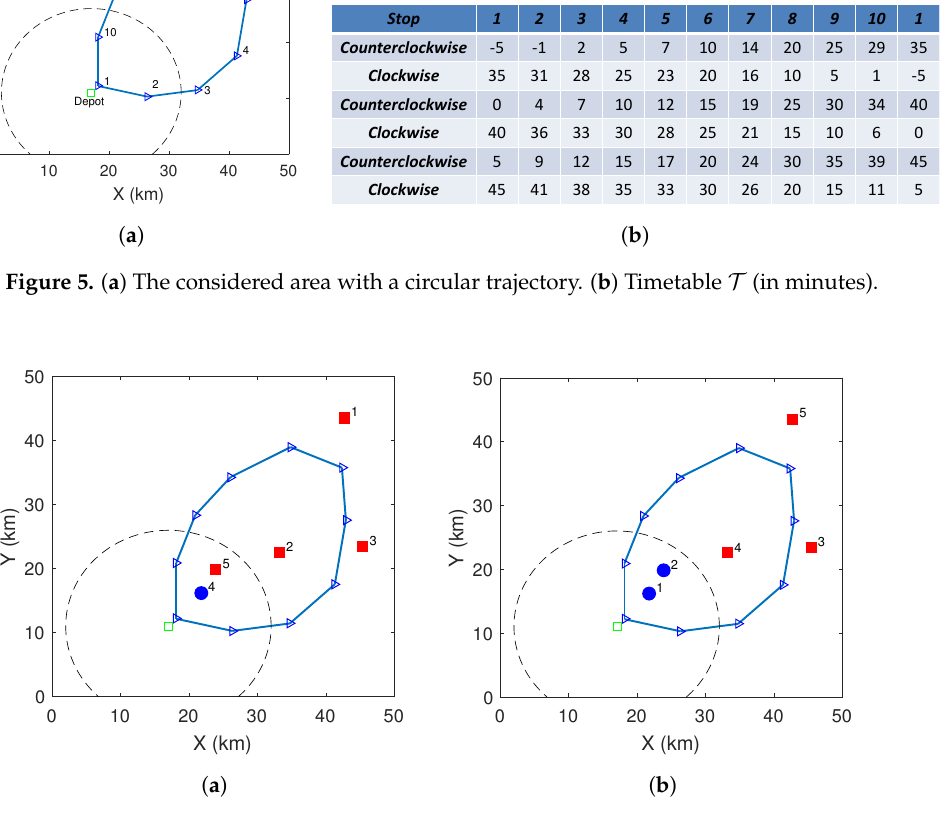
Figure 6. ( a ) Schedule by the exact algorithm. ( b ) Schedule by the sub-optimal